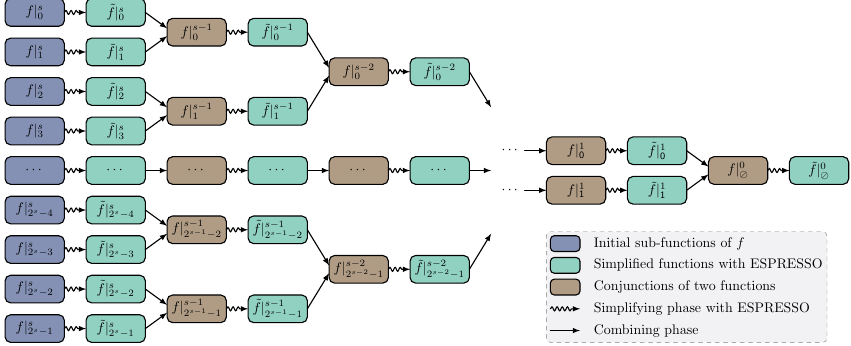
Figure 1: Iterative